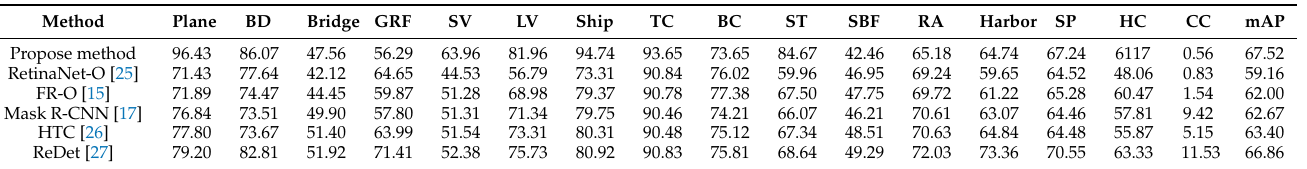
Table 3. The value of AP of various objects.